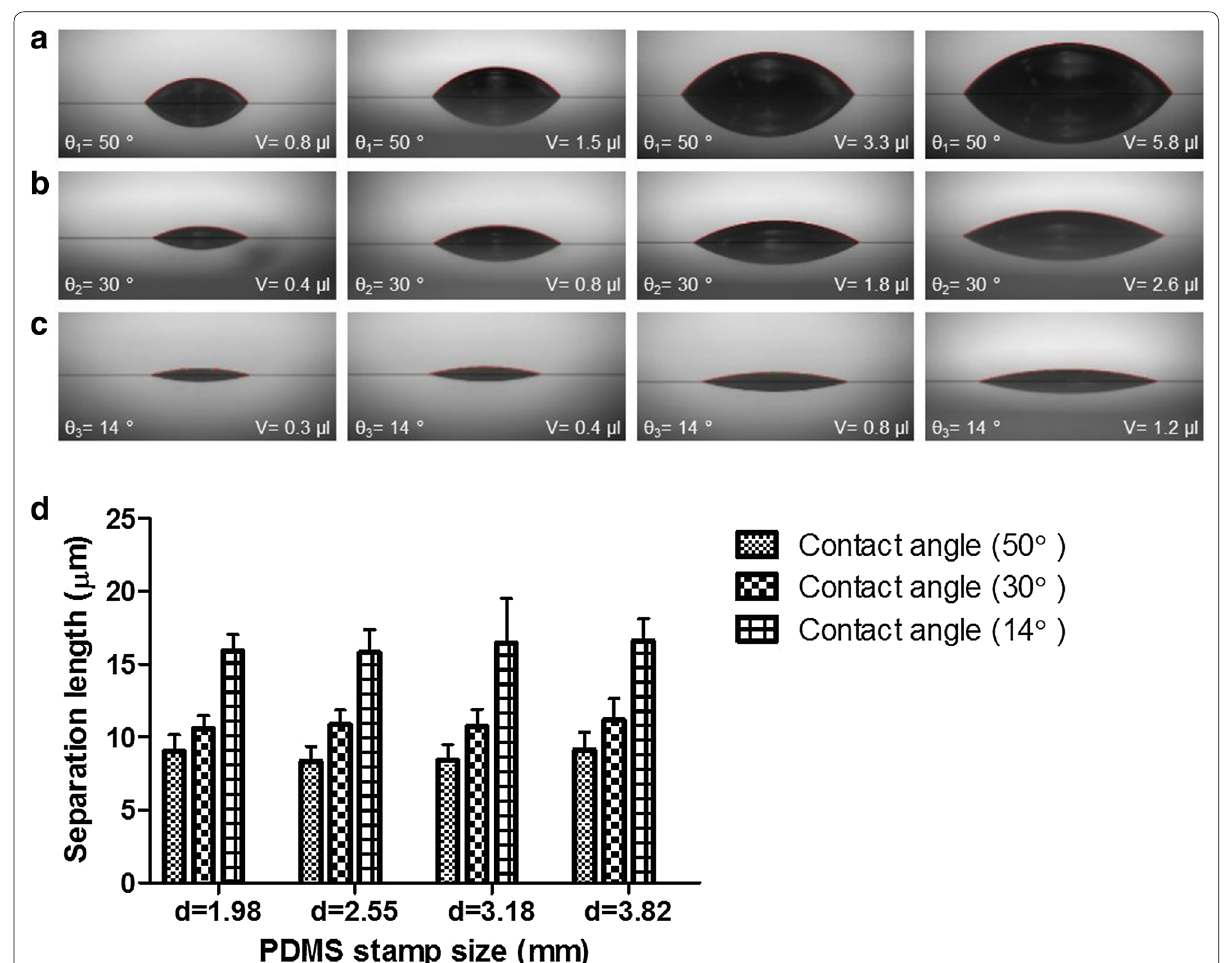
Fig. 4 Image of the droplet with same contact angle but different volumes a θ 1 and 1 µm beads in the evaporated droplet with same contact angle but different